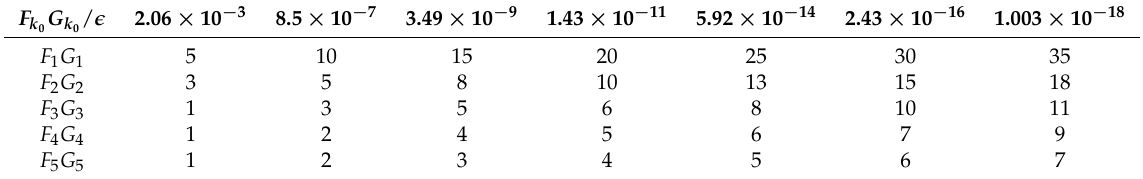
Table 7. Subdivision depth of 2-point ternary subdivision surfaces.